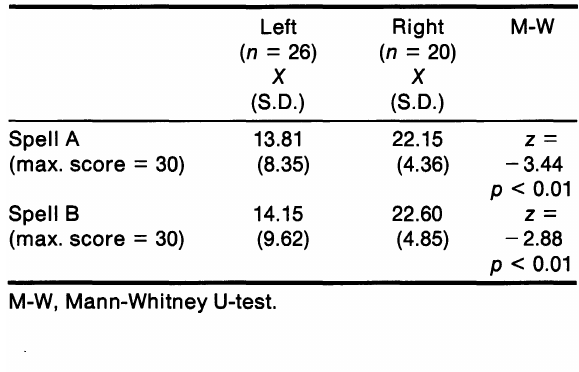
M-W, Mann-Whitney